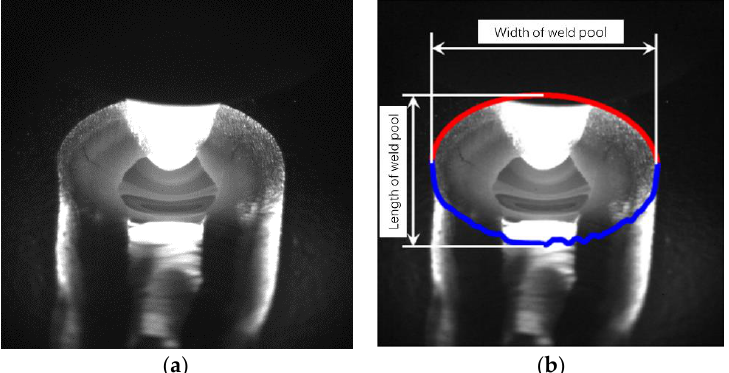
Figure 10. Processing of images to obtain dimensions of weld pools: ( a ) an image captured; and ( b ) feature extraction of weld pools.